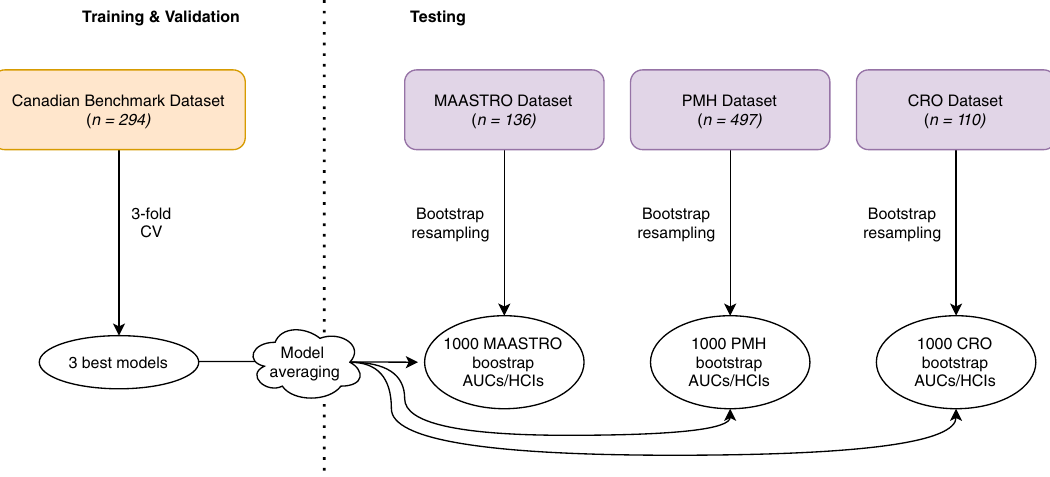
Figure 1. Cohorts training, validation and testing subdivision and analysis workflow. Firstly, the Canadian dataset used by Diamant et al. 22 was used for 3-fold CV to find the hyper-parameters leading to the 3 best validation models. Then, the best validation models were applied to 1000 bootstrap samples of each of the 3 independent testing sets. The predictions of the 3 validation models for each bootstrap sample were averaged to obtain one model averaged prediction per bootstrap replicate. Prediction performance on one cohort was evaluated in terms of area under the curve (AUC) for binary classification and Harrell’s concordance index (HCI) for time-to-event